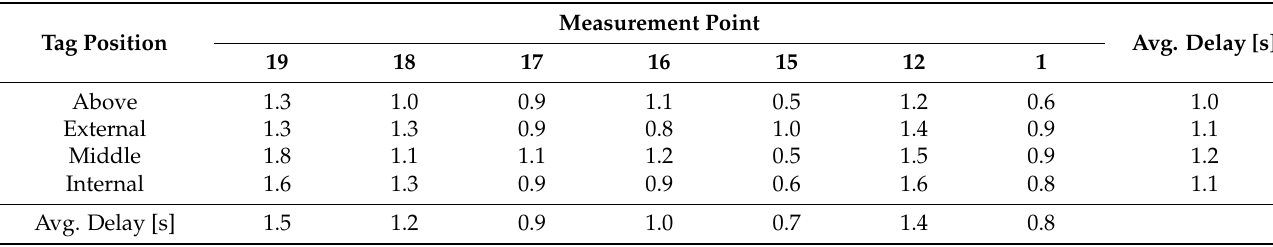
Table 4. Average delay for each point as a function of the tag